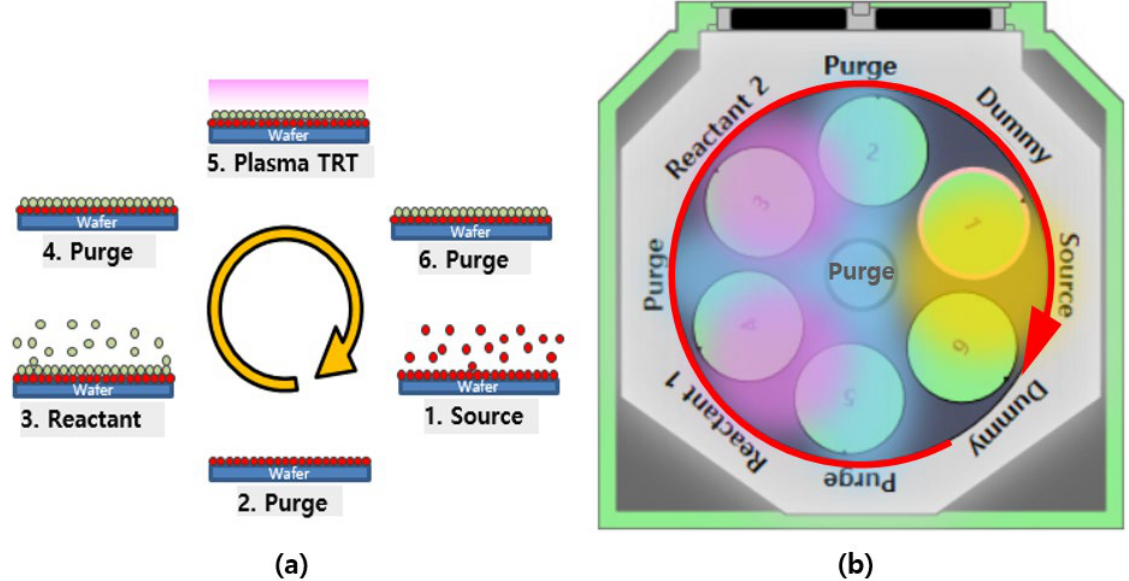
Figure 3. ( a ) Principle of PE-ALD. ( b ) The space division PE-ALD sequence.